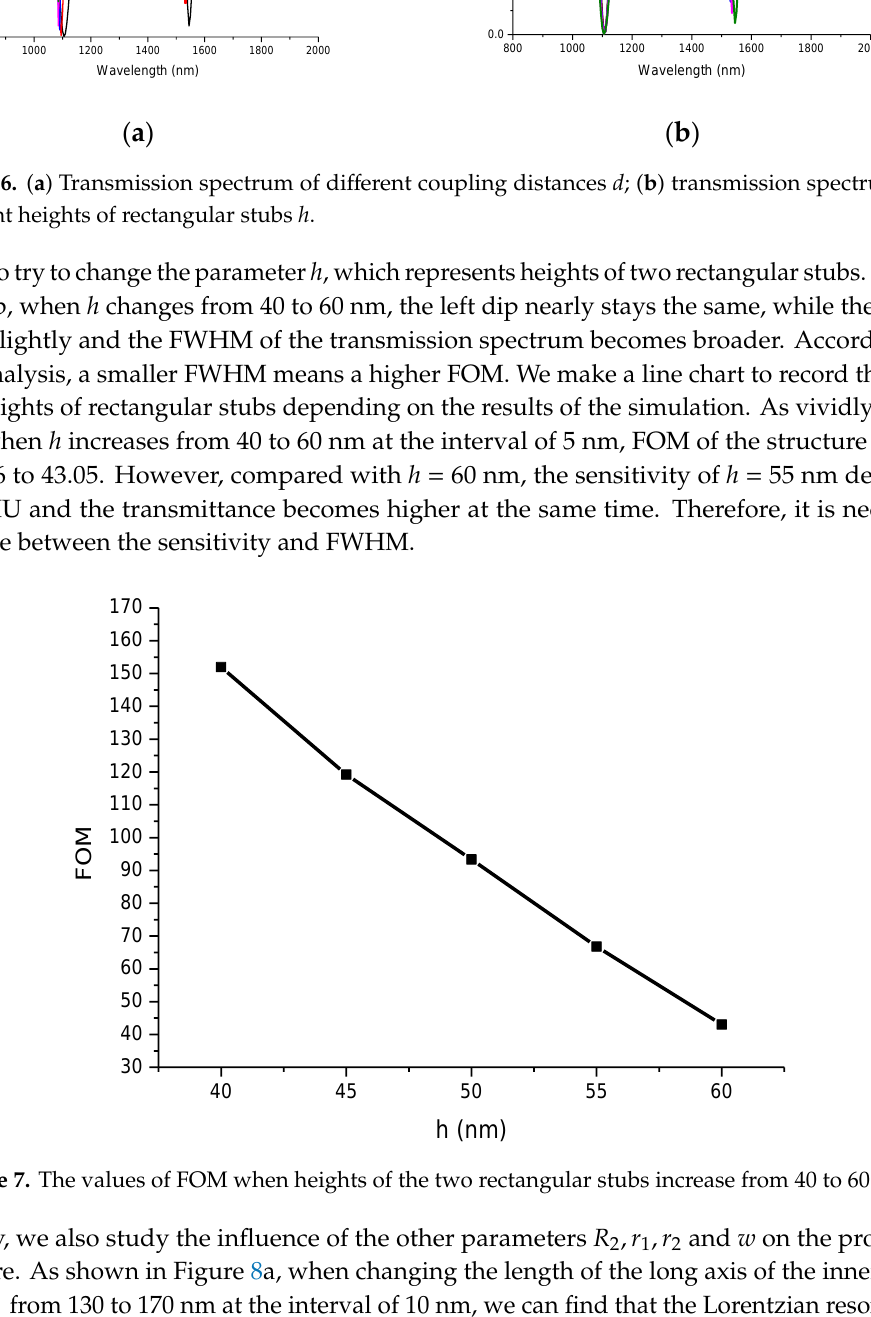
Figure 7. The values of FOM when heights of the two rectangular stubs increase from 40 to 60 nm.